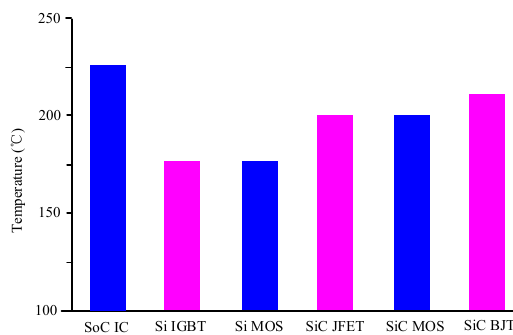
Figure 2. The maximum operating temperature of SiC power electronic devices